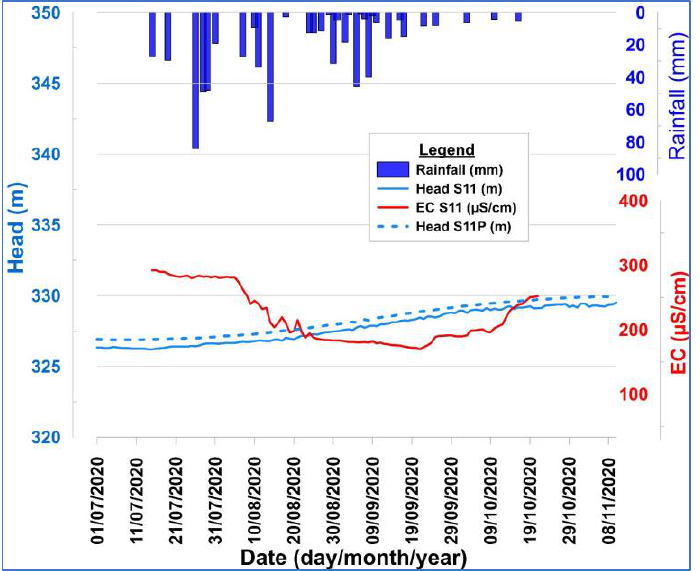
Figure 15. Groundwater hydrographs versus electrical conductivity in relation to rainfall at the southern ridge.